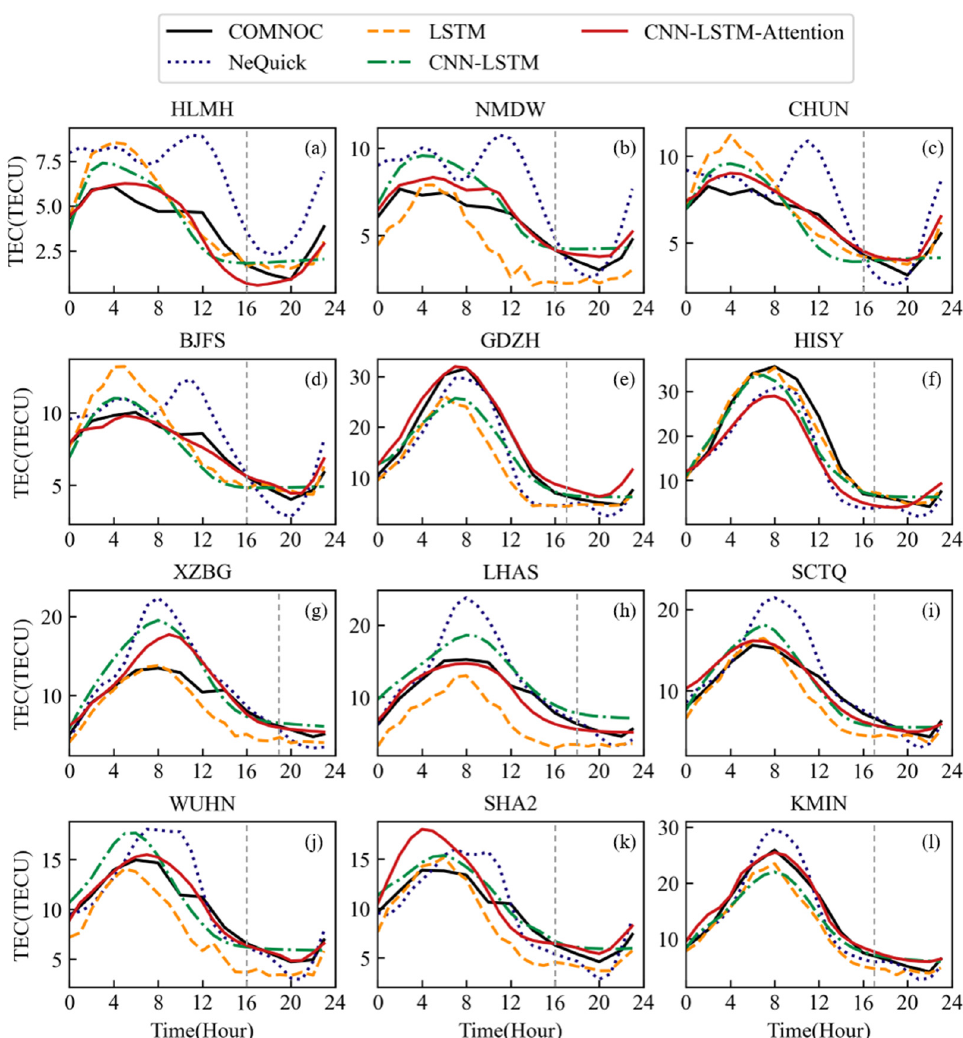
Figure 11. ( a – l ) Comparison of GNSS measured values (black solid line), NeQuick (blue dotted line), LSTM (yellow dotted line), CNN-LSTM (green dotted line), and CNN-LSTM-Attention (red solid line) models forecasted values for 12 stations on magnetic quiet day. The gray dotted line indicates midnight LT.